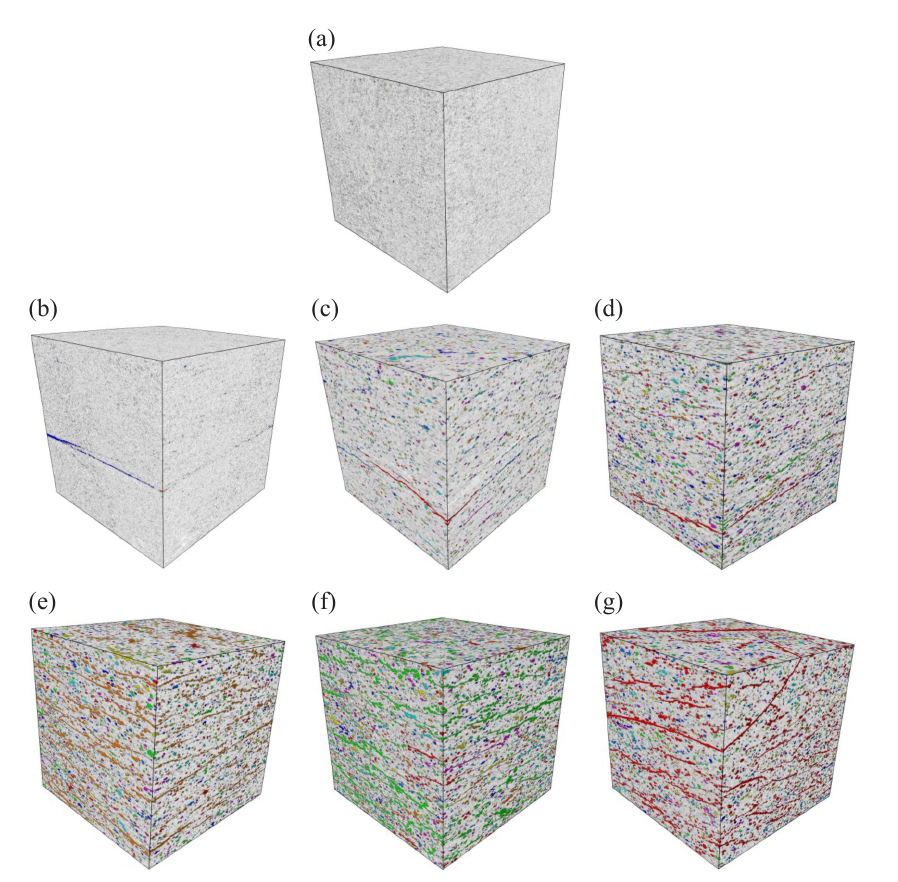
Fig. 5. Three-dimensional volume-rendering digital core of oil shale (the pore and fracture spaces are shown in different colours): (a) original sample (25 °C) (porosity 0.08%); (b) 300 °C (porosity 0.2%); (c) 350 °C (porosity 3.70%); (d) 400 °C (porosity 8.18%); (e) 450 °C (porosity 14.85%); (f) 500 °C (porosity:15.97%); (g) 550 °C